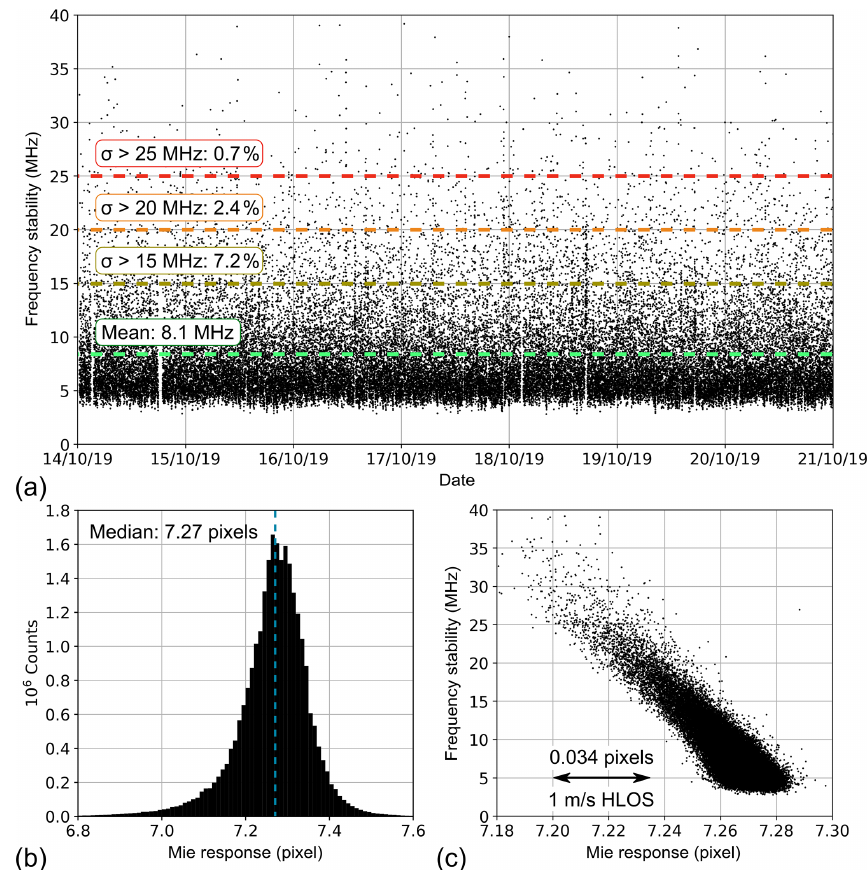
Figure 4. (a) Time series of the laser frequency stability over 1 week from 14 to 21 October 2019, i.e., during FM-B operation. The data points represent σ f (N = 540 ) . Data gaps are due to calibrations or orbit maintenance. The horizontal lines indicate mean over all observations of 8.1MHz (green) as well as thresholds to indicate the percentage of observations for which the frequency stability is worse than 15MHz (yellow), 20MHz (orange) and 25MHz (red). (b) Probability density distribution of the Mie internal reference response for the dataset in October 2019. (c) Relationship between the laser frequency stability in terms of σ f (N = 540 ) and the mean Mie internal reference response per observation. A response shift by 0.034 pixels translates to a frequency shift by about 3.4MHz, corresponding to a HLOS wind speed change of 1ms − 1 , assuming a constant response of the atmospheric or ground return